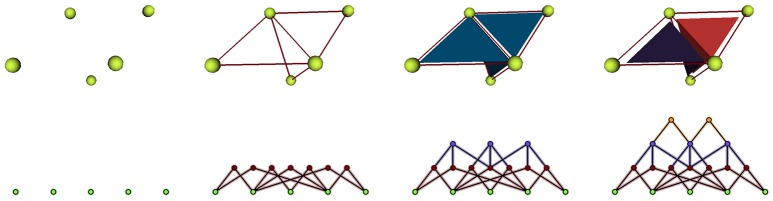
Representation of a mesh containing 2 cells defined by 3 triangular faces as an incidence graph: 3D mesh on the first line, incidence graph representation on the second; the edges defining the triangles are linked to their two extremities, the triangles to their respective edges, and the cells to their boundary triangles.